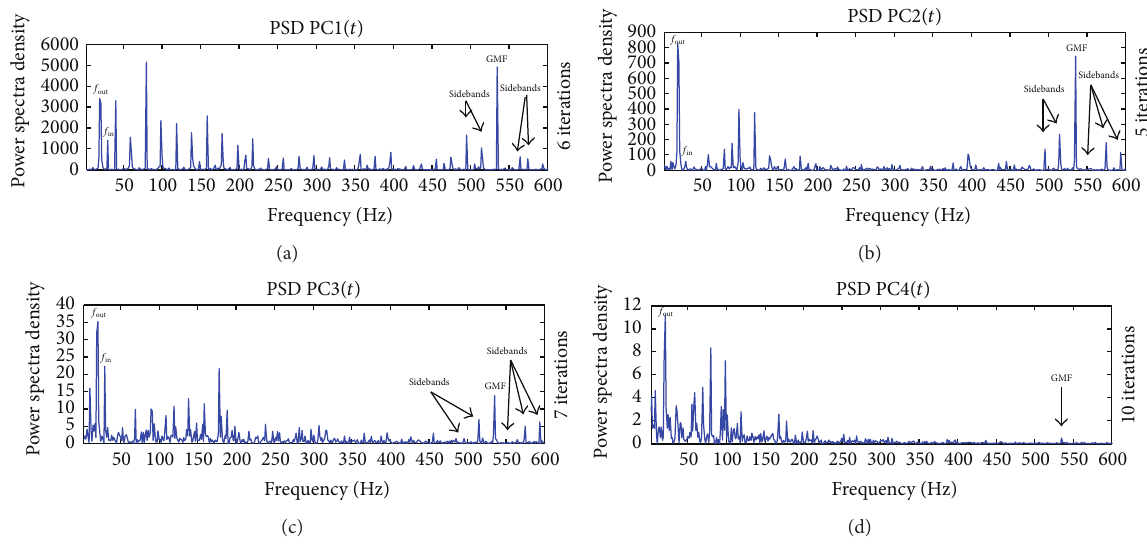
Figure 10: Envelope spectra of the obtained components from ICD (gearbox): (a) PC1( t ), (b) PC2, (c) PC3( t ), and (d) PC4( t ).